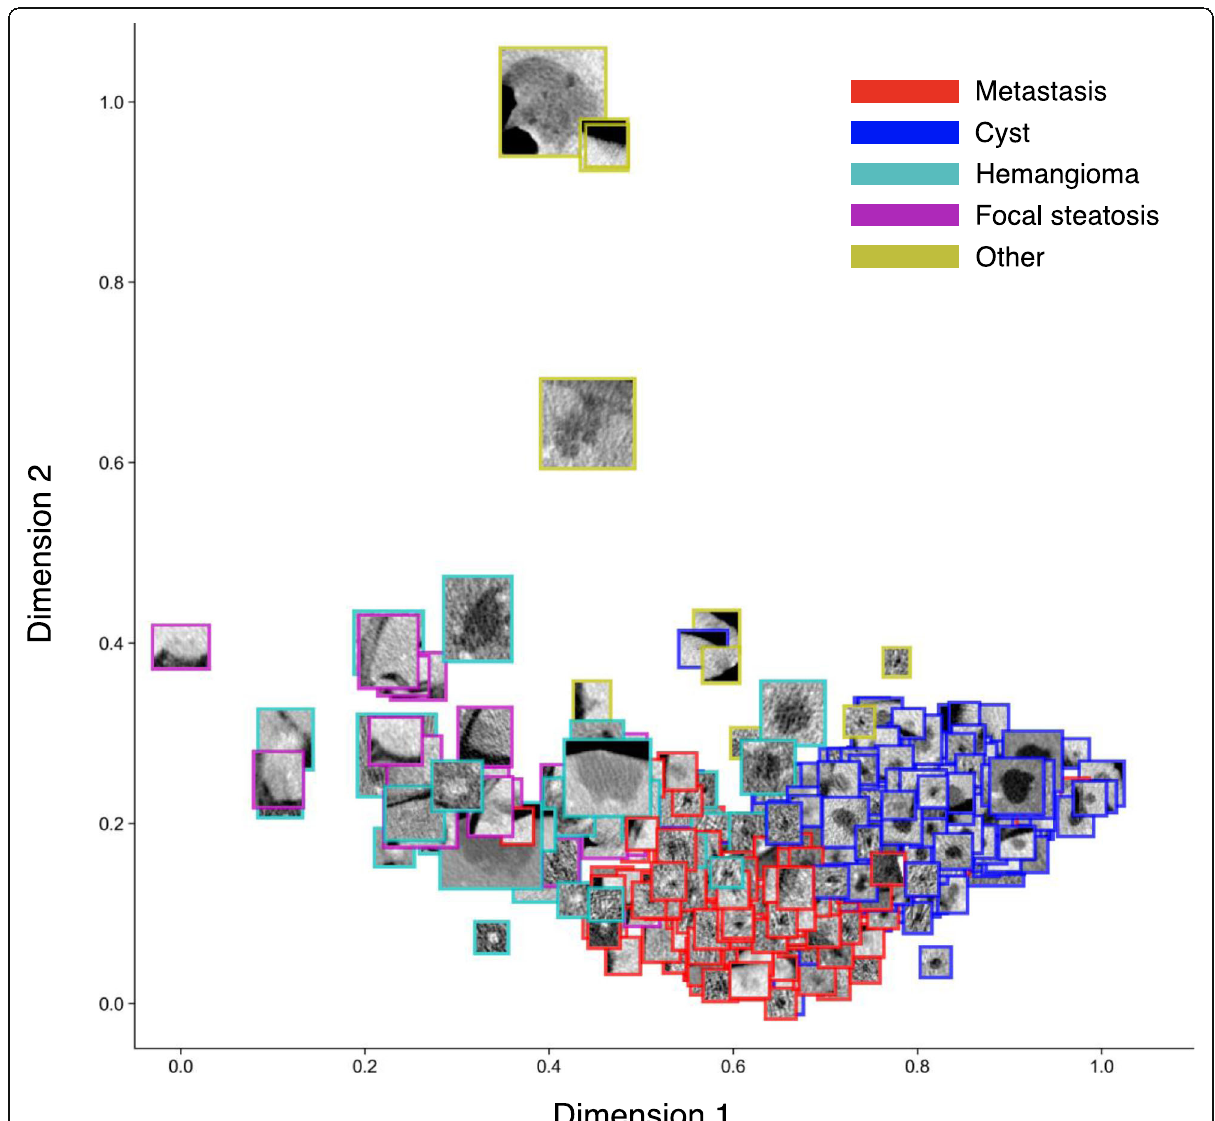
Fig. 5 Example of data visualization: projection on first two dimensions of linear discriminant analysis (LDA) applied to radiomics features extracted from various types of lesions